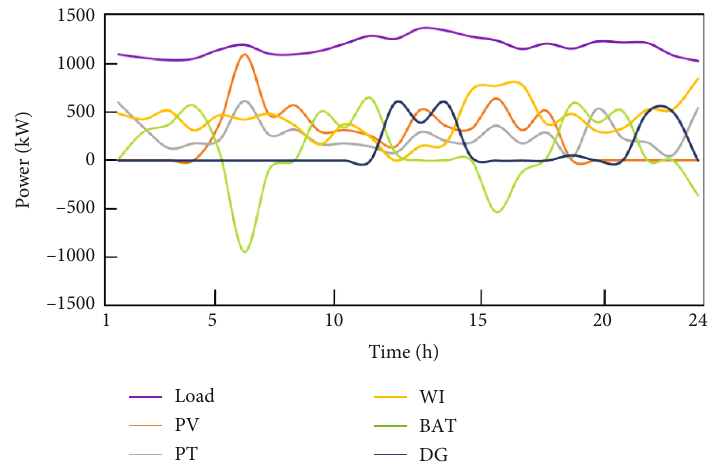
Figure 15: Typical daily distributed power supply output and load of